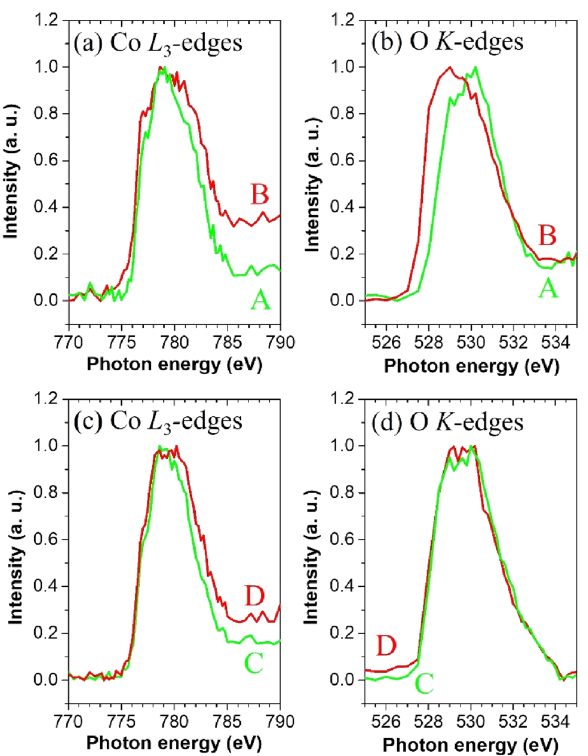
Figure 4. ( a , c ) Co L 3 -edge and ( b , d ) O K -edge spectra extracted from the local rectangular regions (A, B, C, and D) separated by dashed lines shown in Figs. 2c-iii and 3c-iii after charging to 4.5 V,